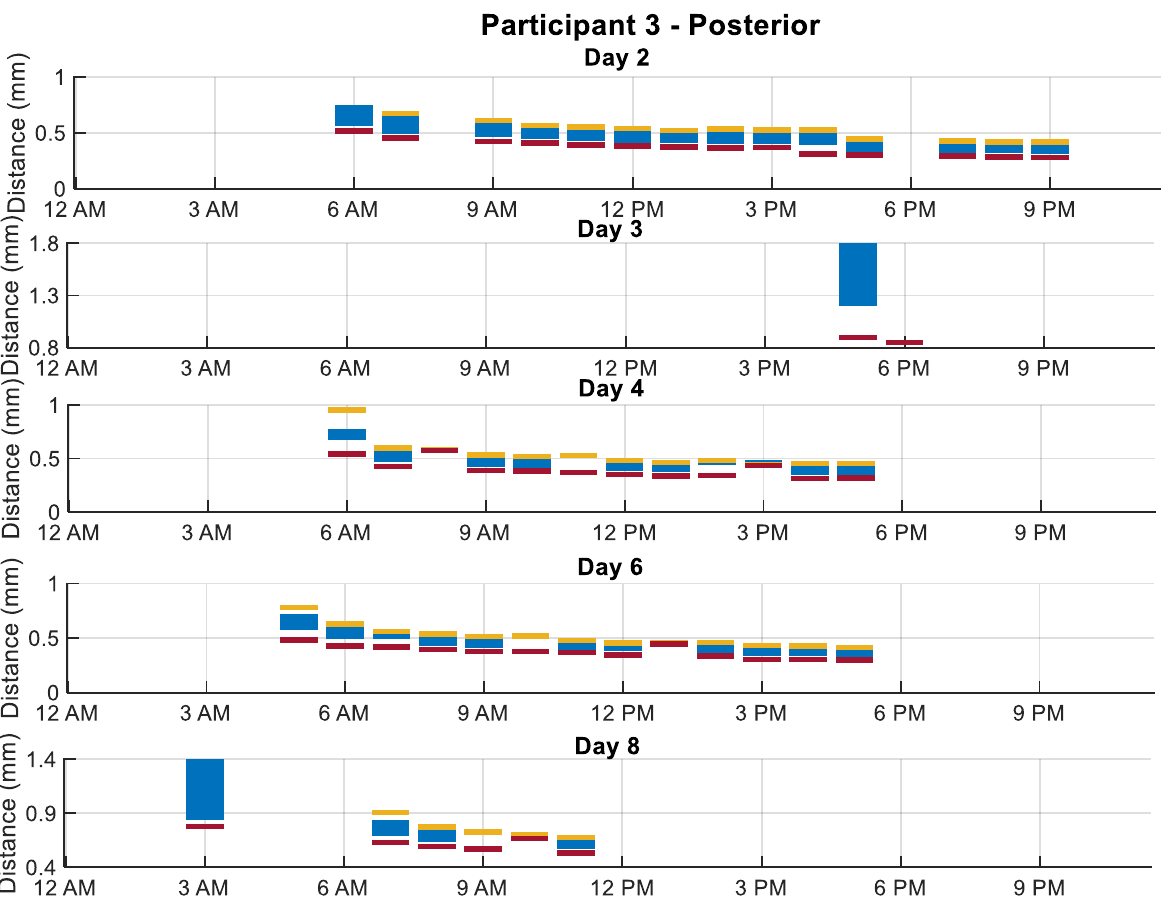
Figure 6. Limb position data by hour for participant 3. The top of a blue bar is the median of the peaks during all steps during the hour, and the bottom is the median of the valleys. The yellow bar is at the 90th percentile of the peaks, and the red bar is at the 10th percentile of the valleys. For this participant, there was a gradual reduction in motion amplitude (length of blue bars) over the day. The limb displaced downward mainly during the morning hours.